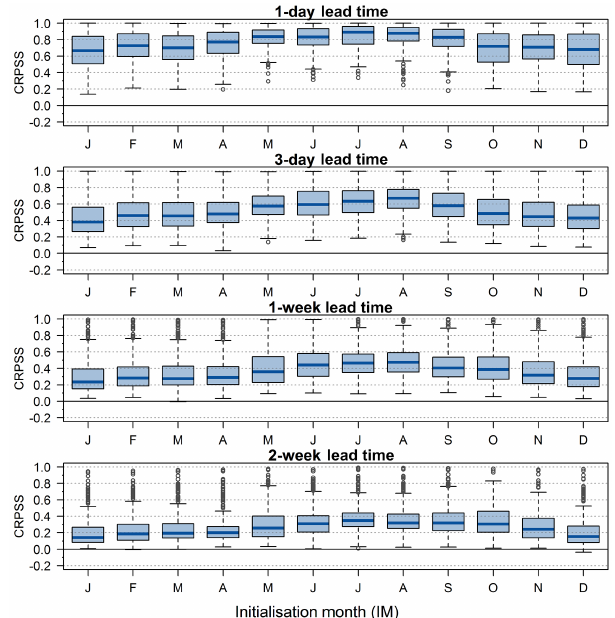
Figure 4. UK-wide ESP skill scores across 314 catchments for each of the 12 forecast initialization months for four short and extended lead times. Boxplots summarize CRPSS values with the blue line representing the median, and boxes the interquartile range (IQR); whiskers extend to the most extreme data point, which is no more than 1.5 times the IQR from the box, and grey circles are outliers beyond this range.